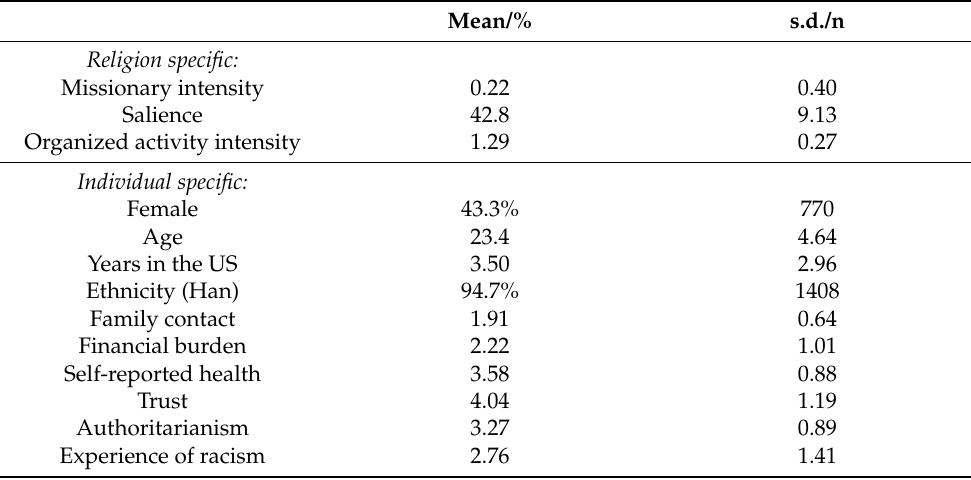
Table 3. Descriptive statistics of the